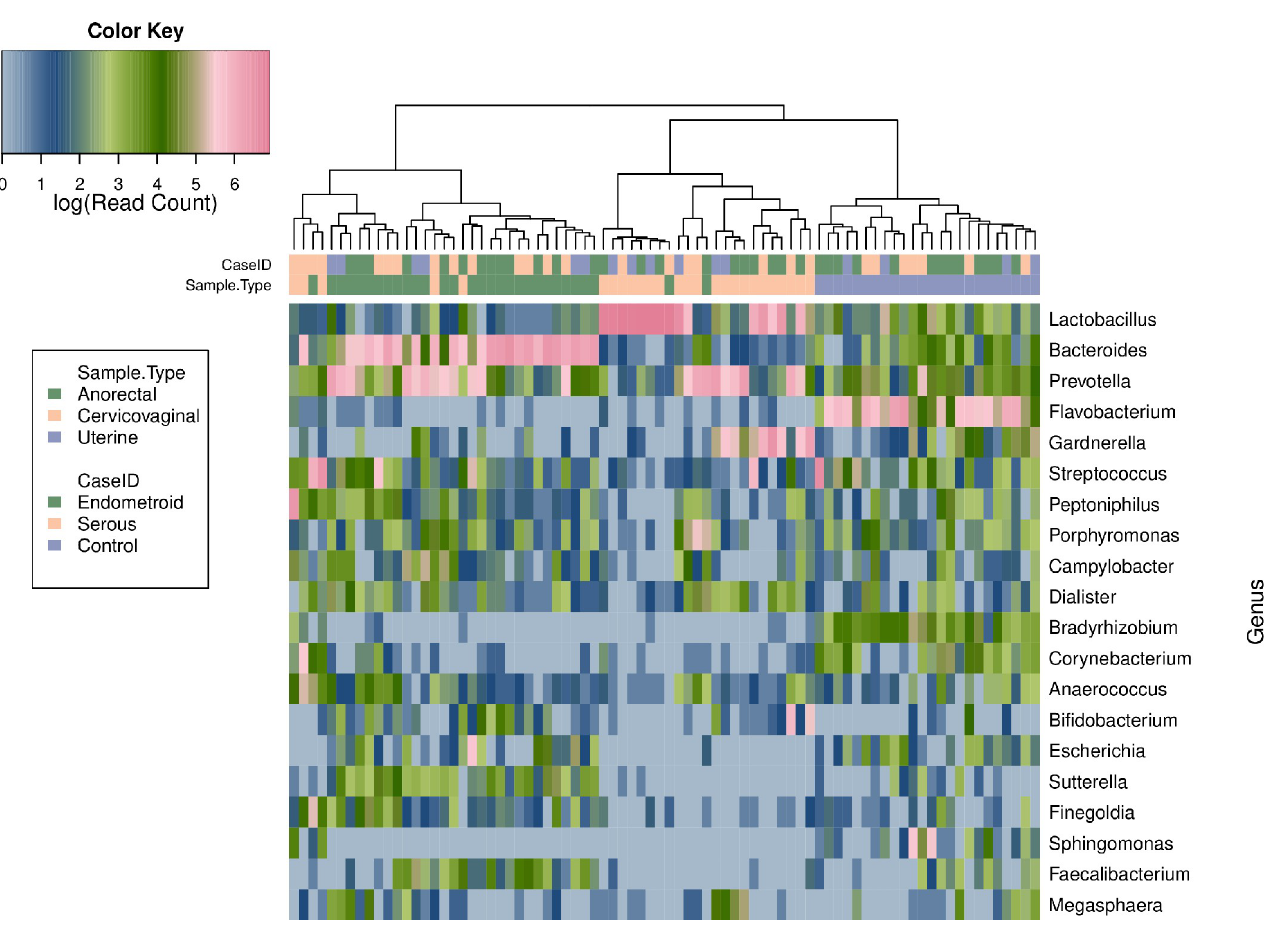
Fig 1. Heatmap of 16S V4 reads from uterine, cervicovaginal and anorectal samples. The 20 most abundant genera of the uterine, cervicovaginal and anorectal microbiota are shown and abundance is represented by color based on a log scale shown at the top left. The names of the bacterial genera are shown at the right of the heatmap. There is a clear separation of the uterine microbiome from the other two niches. The cervicovaginal and anorectal microbiota separate out with the exception of 6 samples.